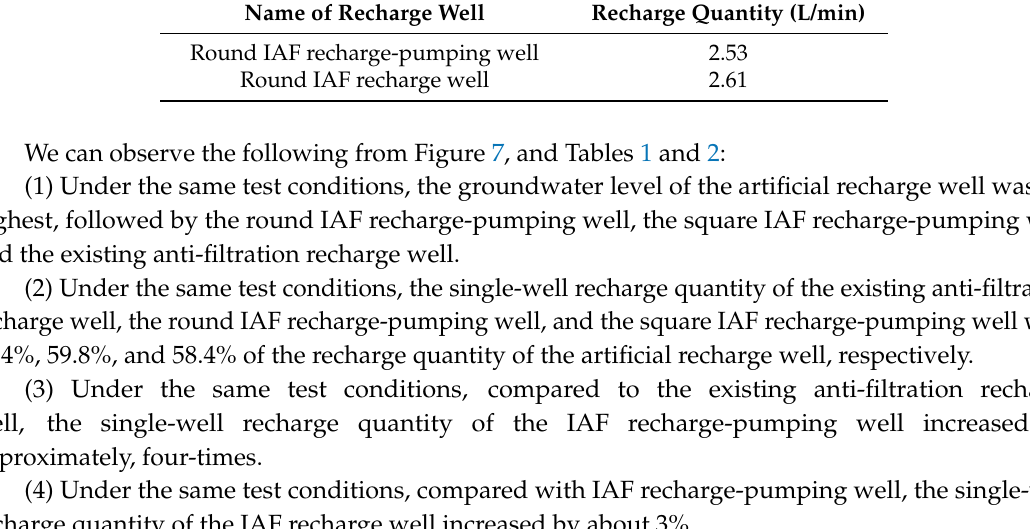
Table 2. Single-well recharge quantity of the comparative recharge test.